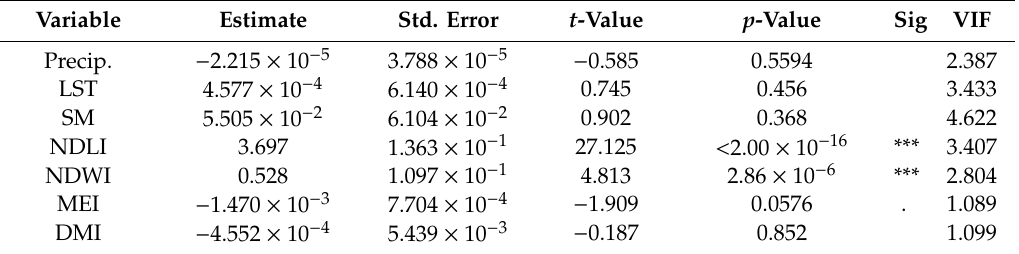
Table 3. The output of the multiple linear regression (MLR) model, in which NDVI was the dependent variable and precipitation, LST, soil moisture, NDWI, NDLI, MEI, and DMI were independent variables. Variable Estimate Std. Error t -Value p -Value Sig VIF Precip. − 2.215 × 10 − 5 3.788 × 10 − 5 − 0.585 0.5594 2.387 LST 4.577 × 10 − 4 6.140 × 10 − 4 0.745 0.456 3.433 SM 5.505 × 10 − 2 6.104 × 10 − 2 0.902 0.368 4.622 NDLI 3.697 1.363 × 10 − 1 27.125 < 2.00 × 10 − 16 *** 3.407 NDWI 0.528 1.097 × 10 − 1 4.813 2.86 × 10 − 6 *** 2.804 MEI − 1.470 × 10 − 3 7.704 × 10 − 4 − 1.909 0.0576 . 1.089 DMI − 4.552 × 10 − 4 5.439 × 10 − 3 − 0.187 0.852